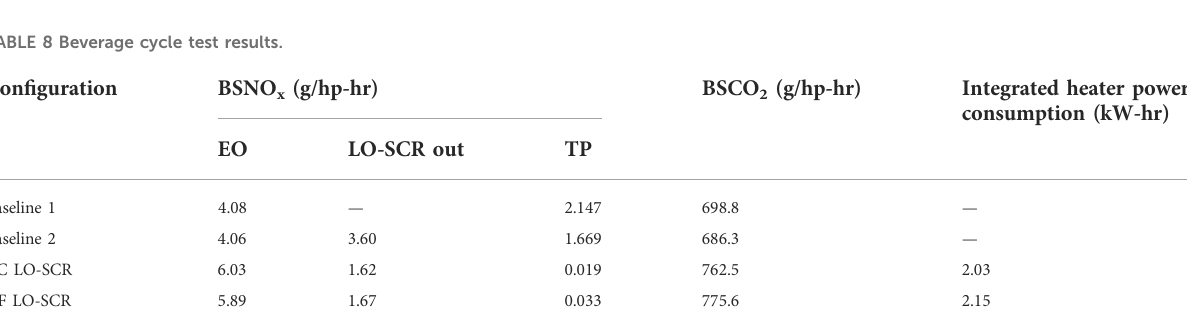
TABLE 8 Beverage cycle test